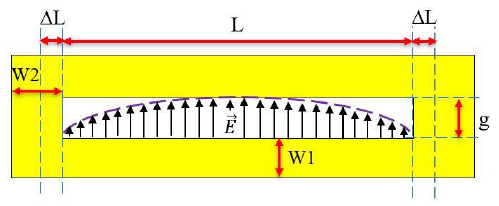
Figure 4. Geometry of the loop scatterer.